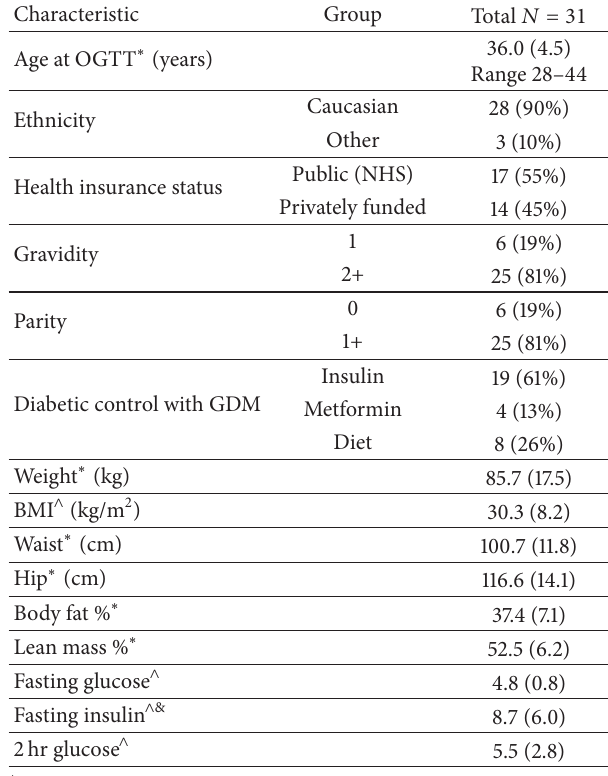
Table 1: Demographic characteristics of women in intervention and control